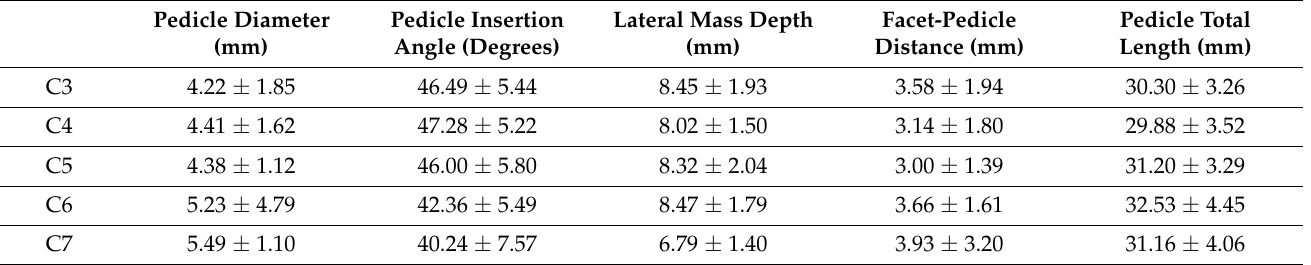
Table 1. Preoperative linear and angular parameters of 271 cervical pedicles. All data are presented as mean ± standard